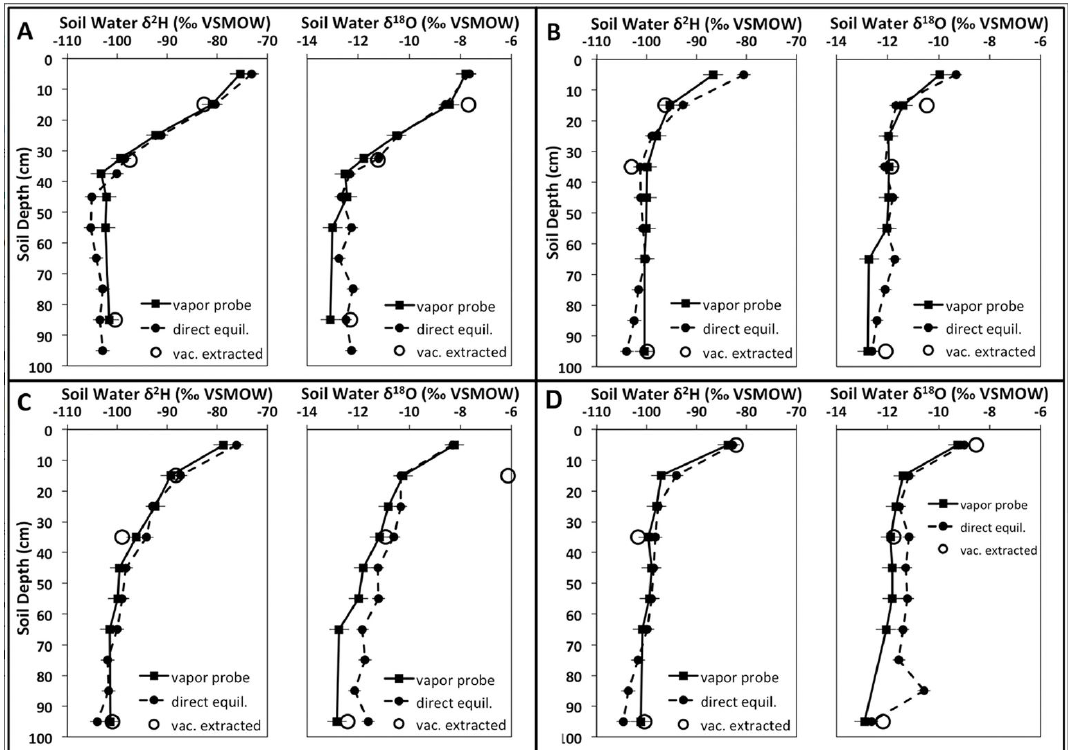
Figure 6. Comparison of soil water δ 2 H and δ 18 O values determined with the soil probes (solid squares and solid line), direct vapor equilibration (or bag equilibration; solid circles and dashed line) and vacuum-extracted soil water (empty circles), with soil depth for four different sites. Analytical uncertainty in each vapor measurement methodology is denoted by horizontal whisker marks. Reprinted with permission from Oerter et al.